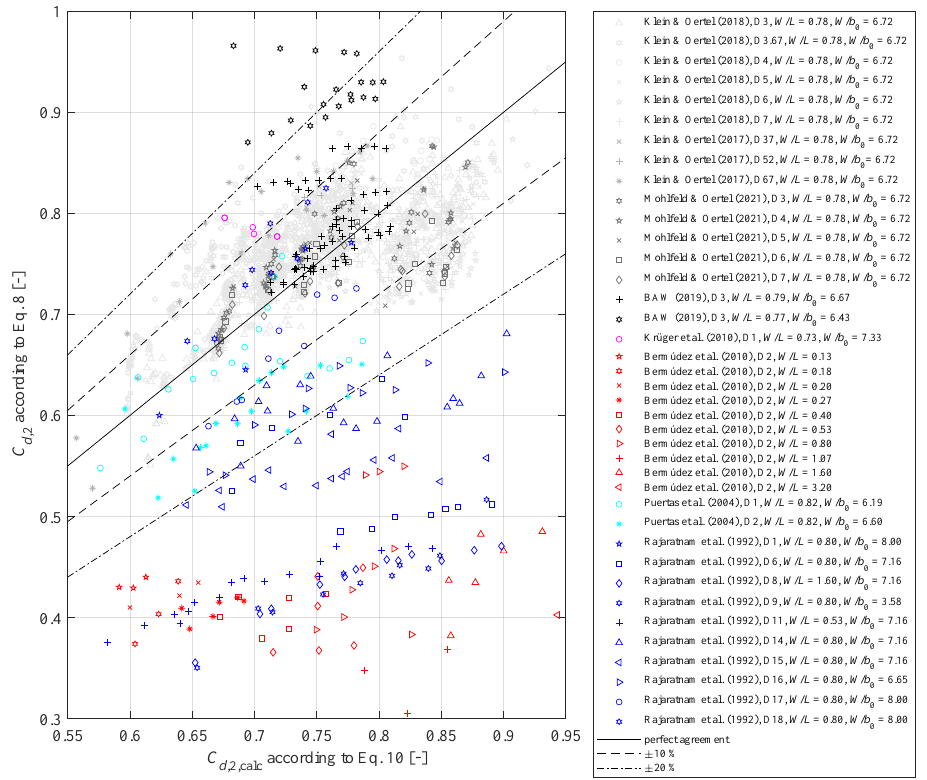
Figure 8. Comparison of calculated discharge coefficients according to Equations (8) and (10) with error bounds of ±10% and ±20%